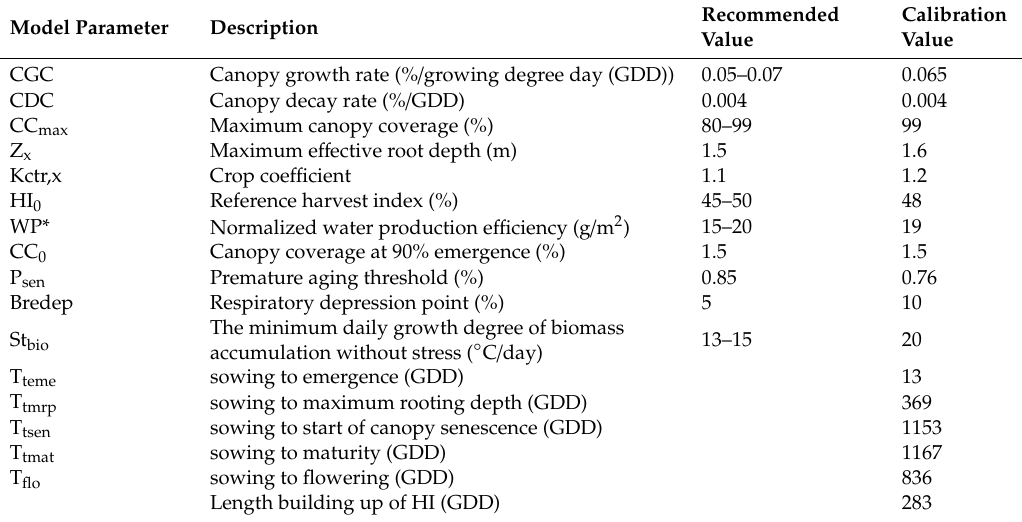
Table 2. AquaCrop model rice main parameter list.